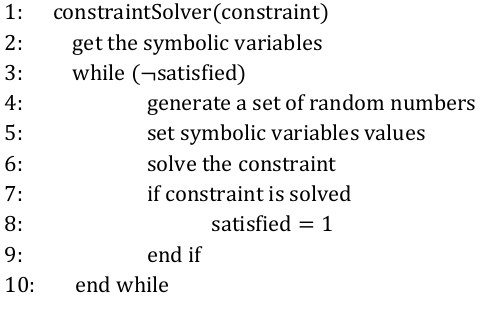
Figure 4 Constraint